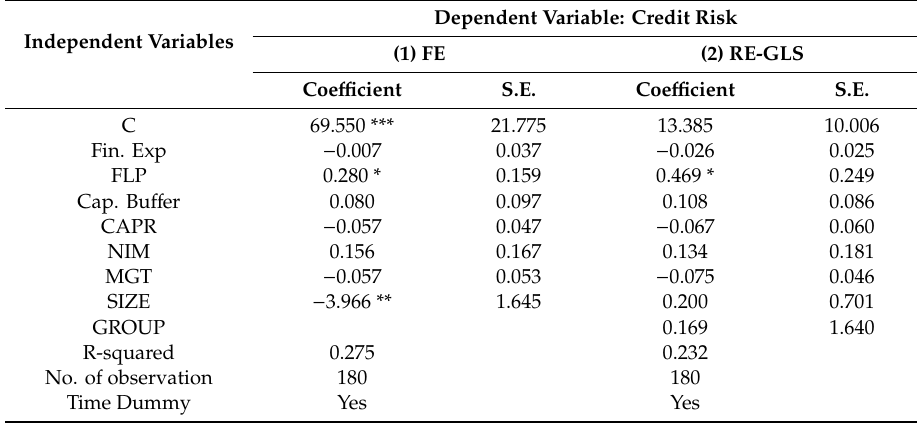
Table 5. Full Sample Regression